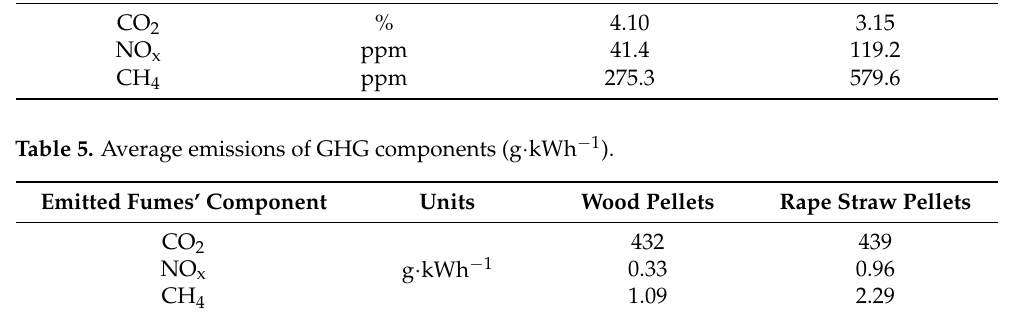
Table 5. Average emissions of GHG components (g·kWh − 1 ).